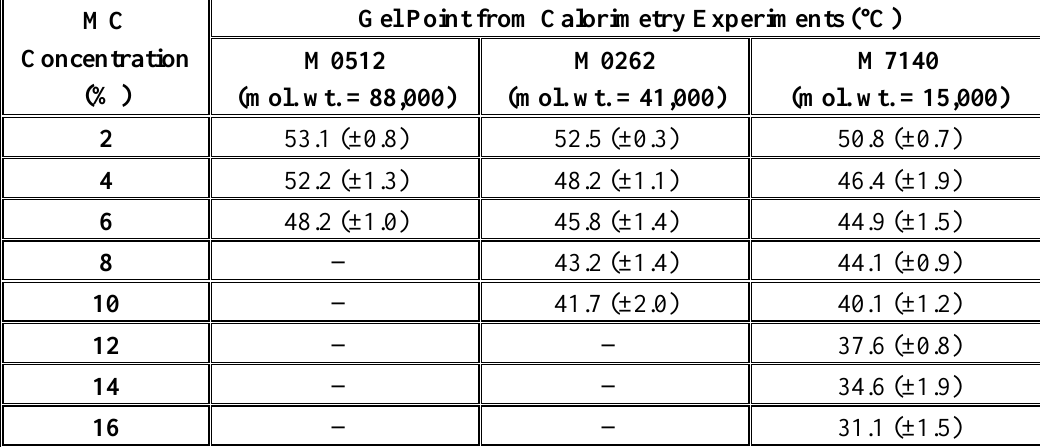
Table 2. Gelation Temperature of the Methylcellulose (MC)-water solutions as a function of molecular weight and